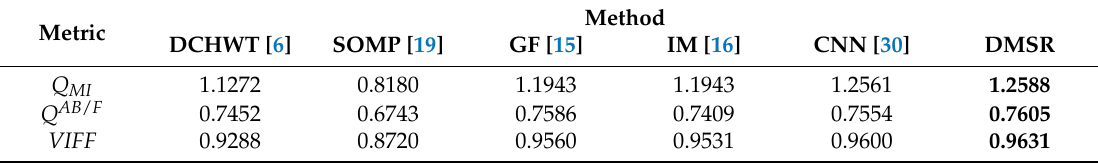
Table 2. Quantitative assessments of di ff erent image fusion methods for three multi-focus